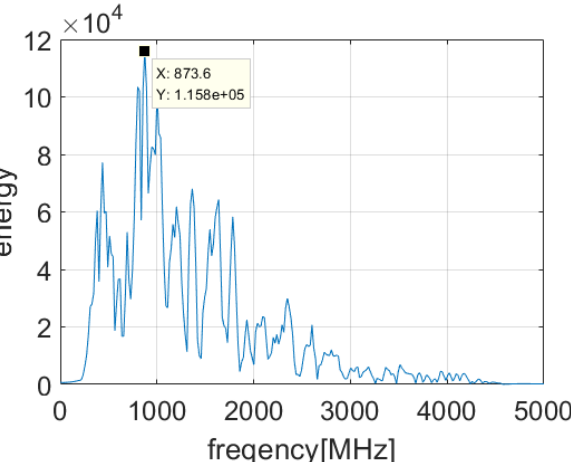
Figure 10. The frequency spectrum of the selected signals. The center frequency 873.6 MHz is used to estimate the loss tangent.